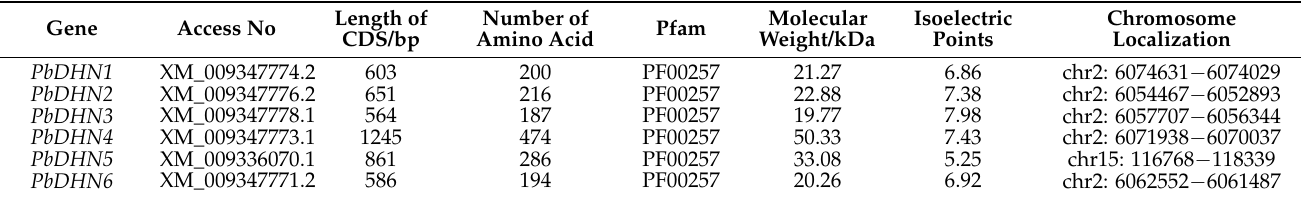
Table 3. Characteristics analysis of PbDHNs .